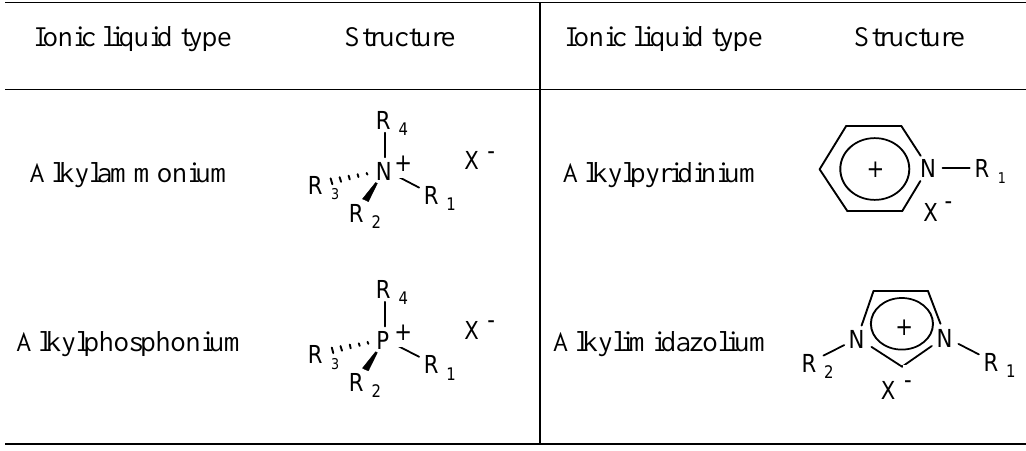
Table 1. Common examples of ionic